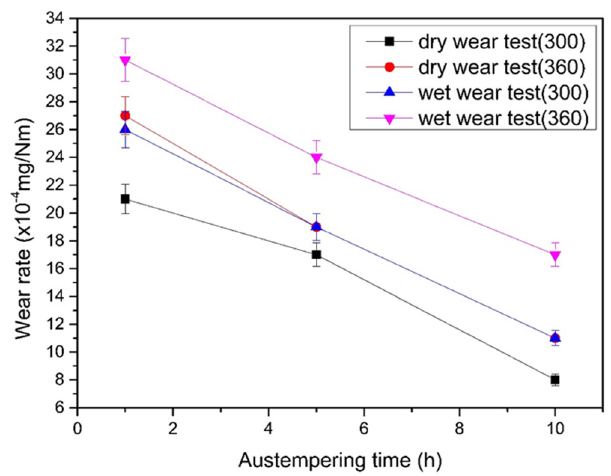
Figure 13. The effects of dry and wet wear types on the wear rate of the ADIs.